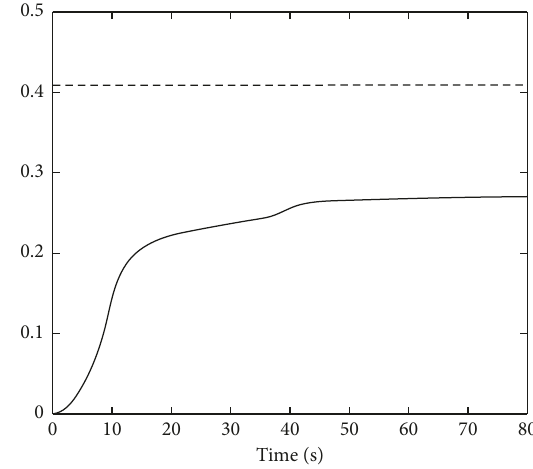
Figure 9: Truncation of